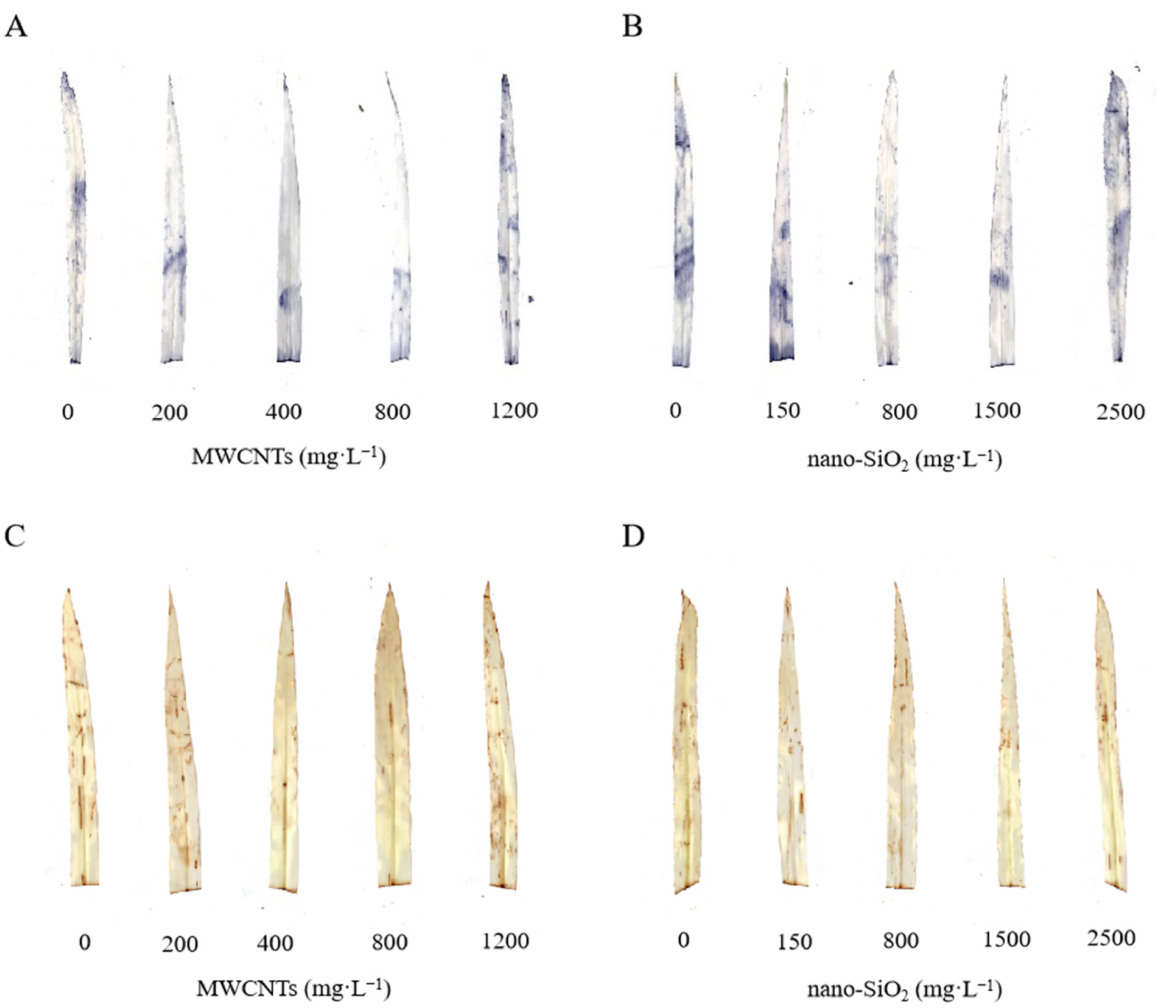
Figure 4. Effect of different concentrations of MWCNTs and nano-SiO 2 on root activity in maize. Note: Data are expressed as mean ± standard deviation. Different letters within the same column indicate significant difference at 5% level.